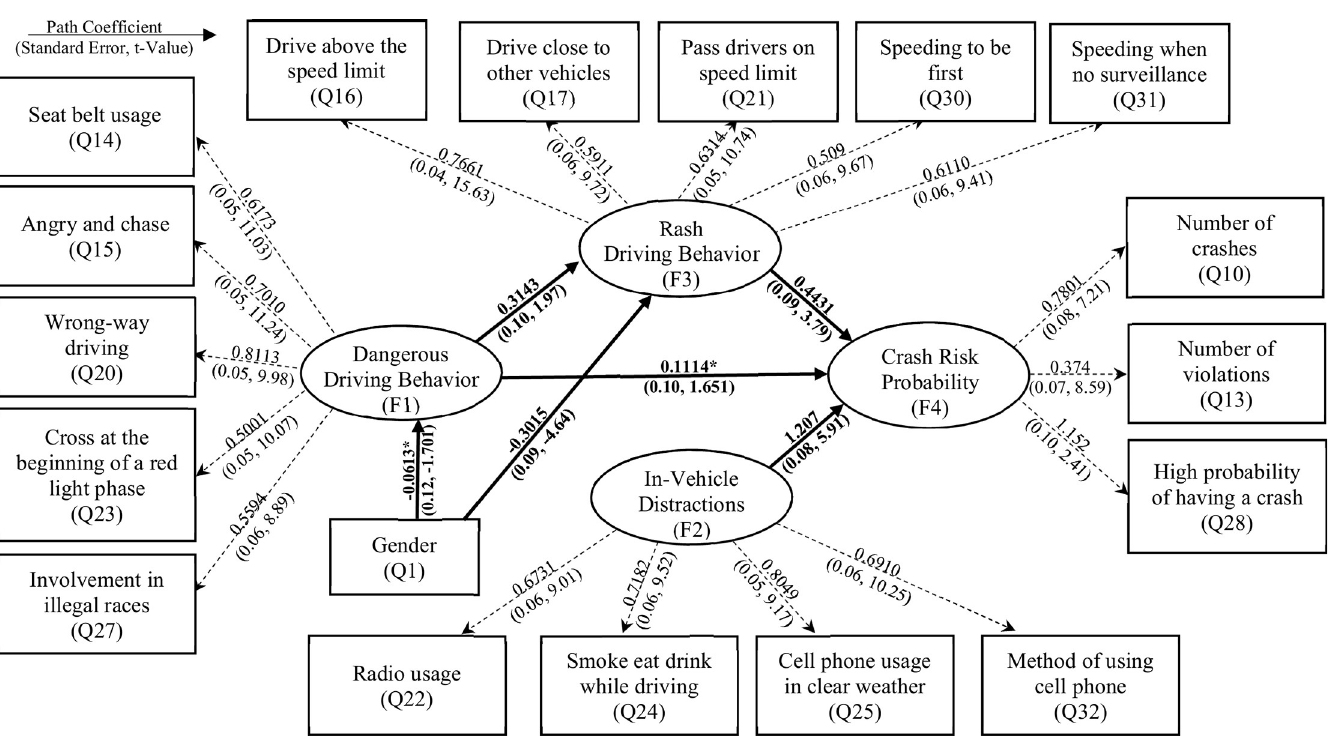
Fig 1. Developed path diagram, path coefficients, and the standard errors for the SEM. https://doi.org/10.1371/journal.pone.0235325.g001 model fit with a value of 0.903. The adjusted GFI value was nearly equal to 0.901, which also